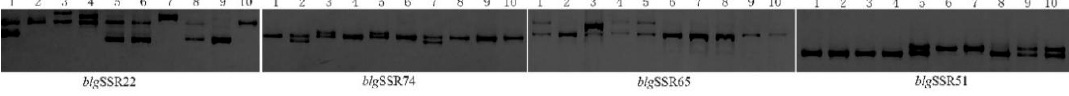
Figure 5. Amplification products obtained from PCR using EST-SSR primers and DNA from 10 Bailinggu wild strains using non-denaturing PAGE. EST-SSR primers are blg SSR22, blg SSR51, blg SSR65, and blg SSR74. Lines 1–10 are wild Bailinggu strains collected from Xinjiang Autonomous Region in China.